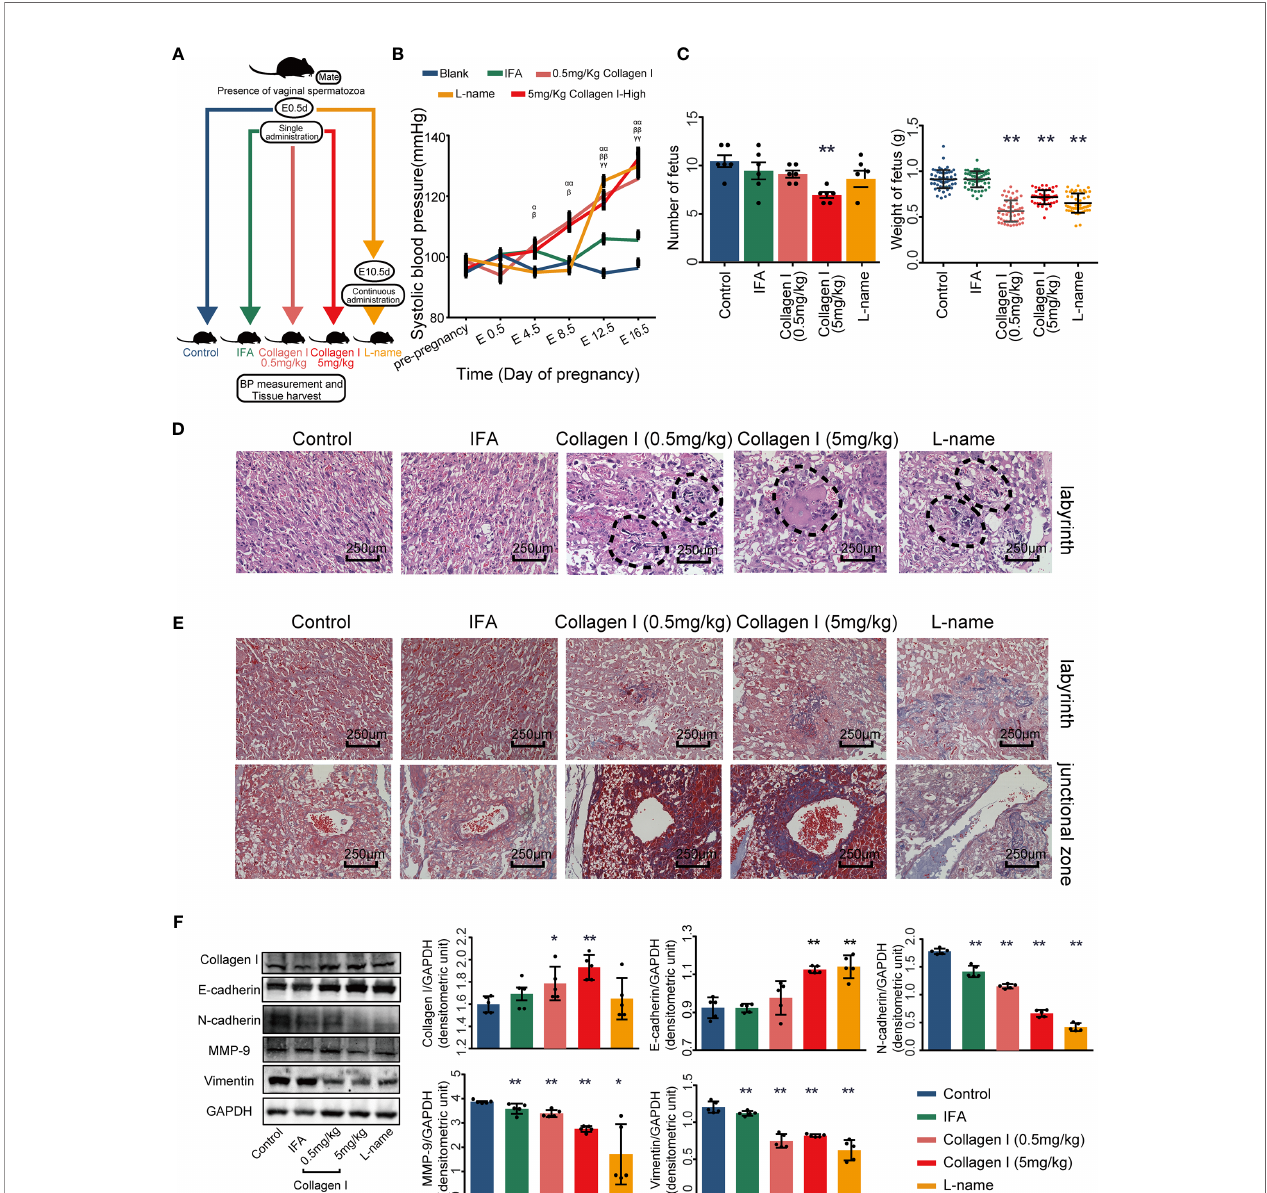
FIGURE 2 | Collagen I induces preeclampsia-likesymptomsin mice. Effects of collagen I on the reproductive outcomes of pregnant mice. (A) Schematic representation of the experimental groups. (B) The systolicbloodpressure of membersof the fi ve groups duringpregnancy (n= 6 per group, a indicates mice treated with 5 mg/kg ofcollagen I vs. control, b indicates mice treated with 0.5 mg/kg of collagen I vs. control, g indicates L-NAME-treated mice vs. control, with a , b , g p < 0.05 and aa , bb , gg p < 0.01, according to two-way repeatedmeasures ANOVA). (C) The number of offspring signi fi cantlydecreased inthe group treated with 5 mg/kg of collagen I (n= 6 per group) comparedwith the control at 17.5 daysof gestation. Fetal weights in the groups treated with 0.5 mg/kg of collagen I (n= 54),5 mg/kg of collagen I (n= 46),and L-NAME (n = 49)were signi fi cantly decreased comparedwith thoseof the control (n= 59) and IFA-treated groups(n = 56). (D) Representative image of the H&E-stained labyrinth zone of mouse placenta. Typical lesionsare marked with dotted lines (originalmagni fi cation,×200; scalebar = 250 m m,n = 4). (E) Representative image of Masson ’ s trichrome staining in the labyrinth and junctionalzone of themouse placenta. (original magni fi cation,×200; scalebar = 250 m m, n = 4). (F) Western blot analysis of the protein levelofcollagen I andthe proteins related to PE pathogenesis includingMMP-9, E-cadherin,N-cadherin,and vimentin (n= 5, asterisksindicate differences between groups vs. control, with *p < 0.05, **p < 0.01, according to one-way ANOVA followed byDunnett post-hoc